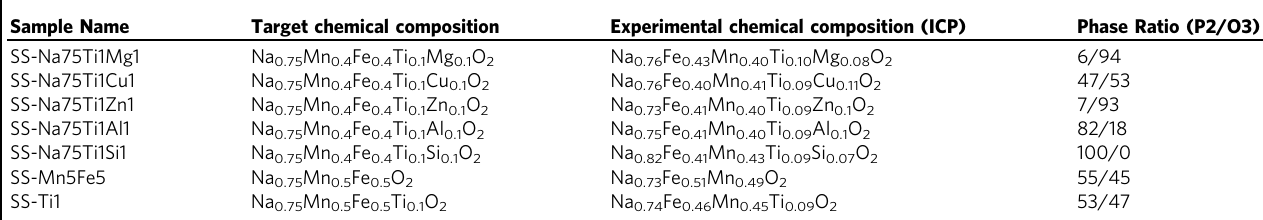
Table 2 Solid-state synthesized materials with their sample names, target chemical composition, and actual chemical composition. Sample Name Target chemical composition Experimental chemical composition